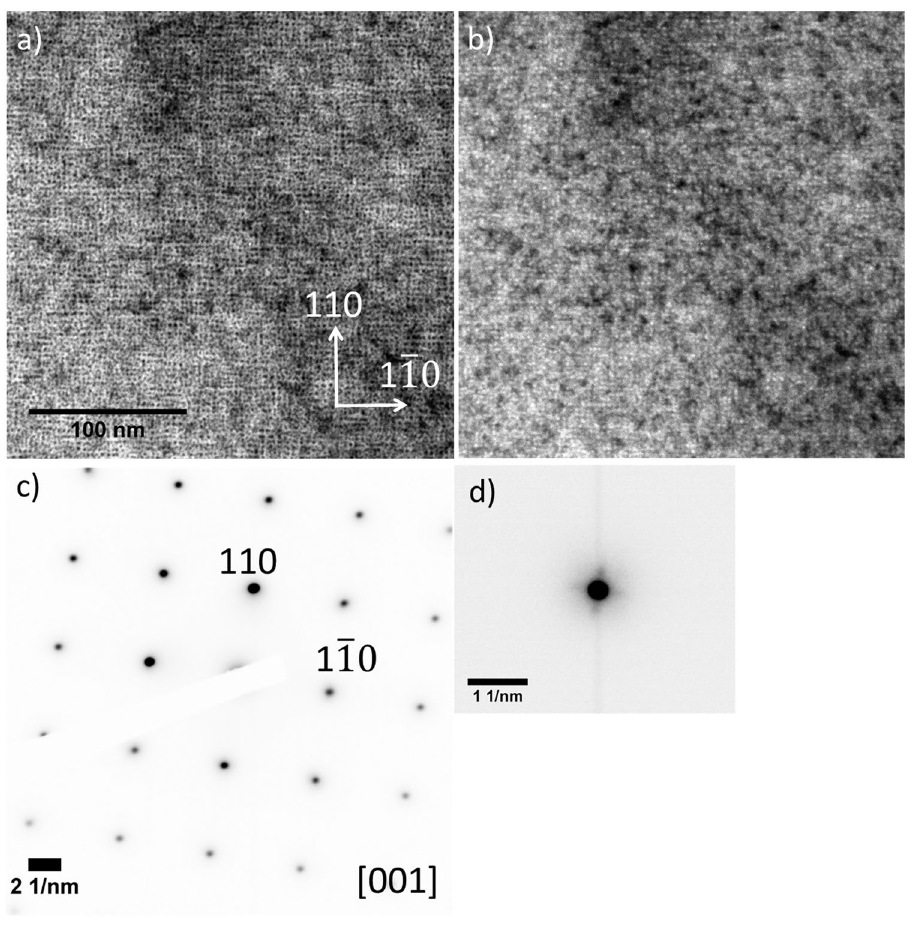
Figure 2. W sample irradiated with 15 keV He ions at 773 K up to 1.1 × 10 17 ions.cm − 2 to 3.0 DPA: ( a ) BF-TEM image of a He bubble lattice taken at 1.2 μ m overfocus; ( b ) BF-TEM image of a He bubble lattice taken at 1.2 μ m underfocus; ( c ) SADP of the region in (a); and ( d ) DP of the He bubble lattice around the 000 spot. The scale marker in (a) applies to both micrographs.